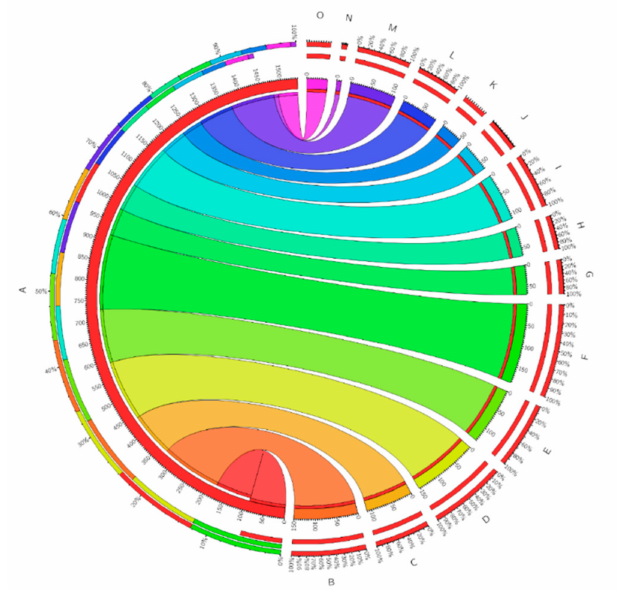
Figure 17. Request submitted to the cloud of the proposed